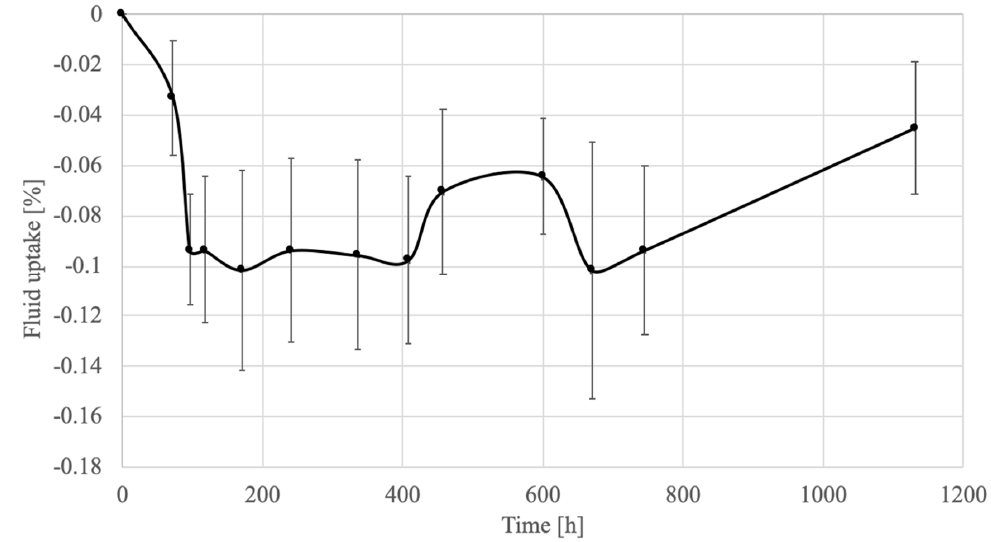
Figure 6. Experimental results of the gravimetric analysis in dielectric fluid.